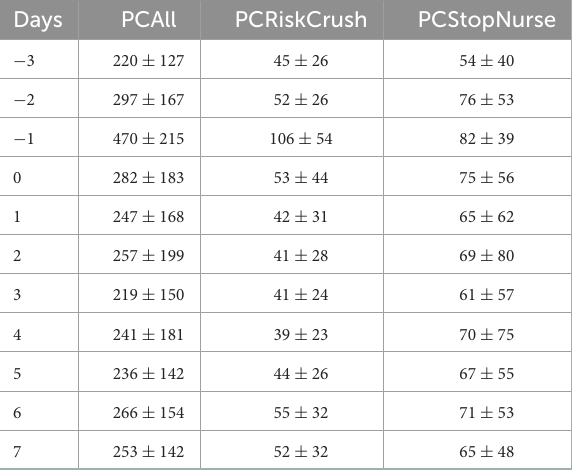
TABLE 2 Mean number of postural changes ( ± SD) for each category of posture change. Days PCAll